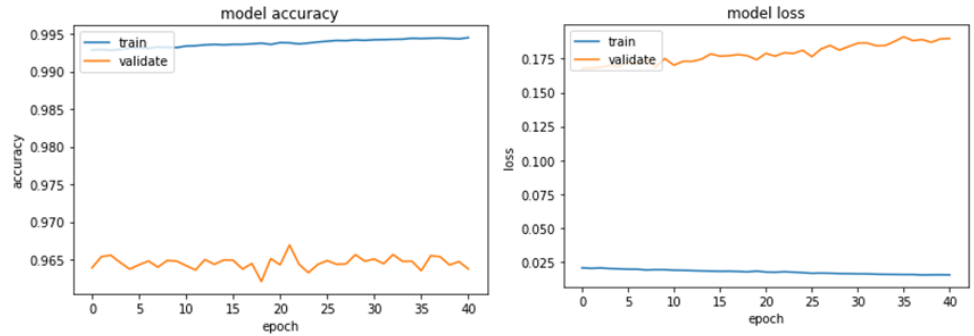
Figure 8. Training and validation loss curves on LSTM model.